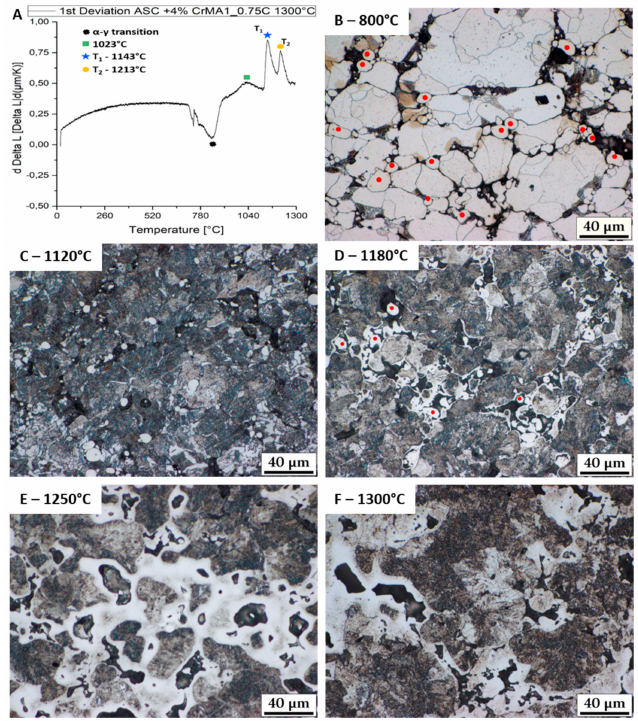
Figure 2. Fast heating experiment (120 K/s) with ASC + 4% CrMA1_0.75C nom (0.72C comb ). ( A ) 1st Dev of the dilatometer (heating segment) ( B ) 800 ◦ C presintered in pusher furnace. Starting point (red dots mark MA particles) ( C ) Sample quenched from 1120 ◦ C, ( D ) Sample quenched from 1180 ◦ C, ( E ) Sample quenched from 1250 ◦ C and ( F ) Sample quenched from 1300 ◦